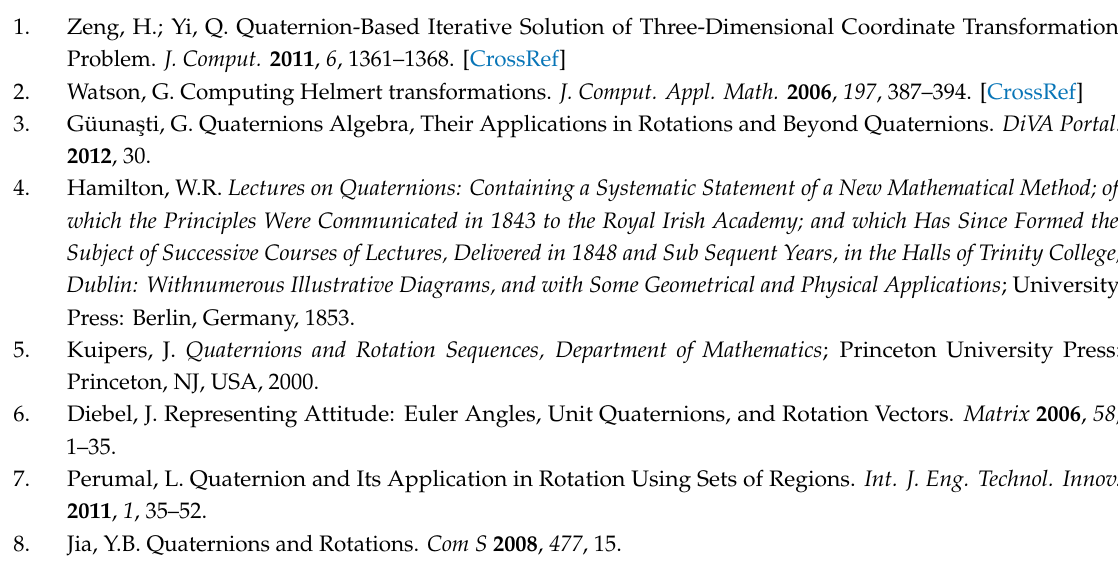
Figure 13. Histograms of deviations and uncertainty in the real data example for all Helmert transformation parameters.